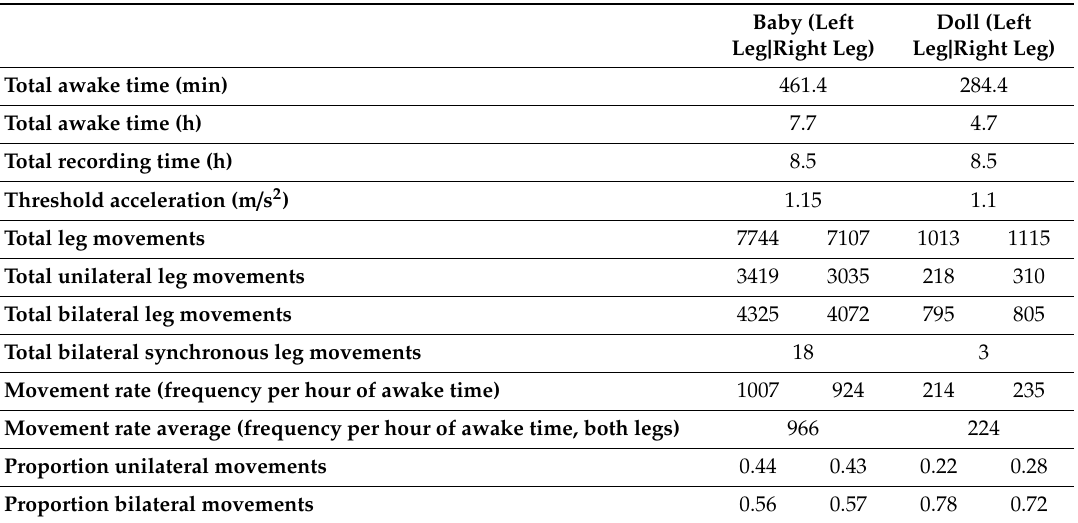
Table 1. Awake time and frequency of movements across a full day.